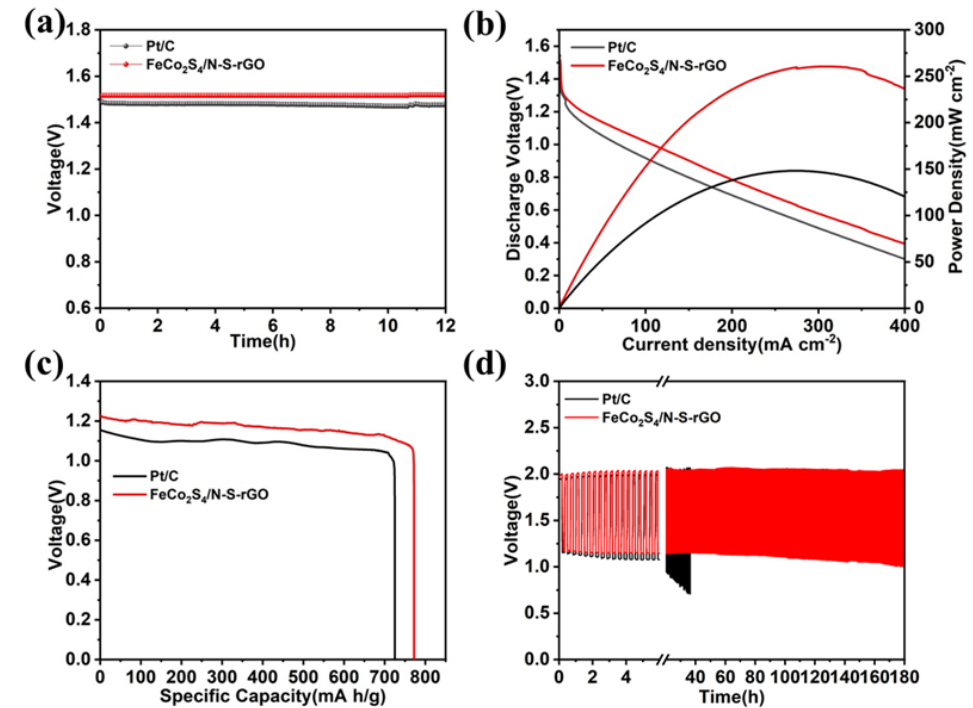
Figure 4. ( a ) LSV open-circuit potential versus time curves of FeCo 2 S 4 /N-S-rGO and Pt/C; ( b ) power density curves of FeCo 2 S 4 /N-S-rGO and Pt/C; ( c ) specific capacity of FeCo 2 S 4 /N-S-rGO and Pt/C in a zinc – air battery at 10 mA cm −2 ; ( d ) charge and discharge time experiments of FeCo 2 S 4 /N-S-rGO and Pt/C in a zinc – air battery at 10 mA cm −2 .